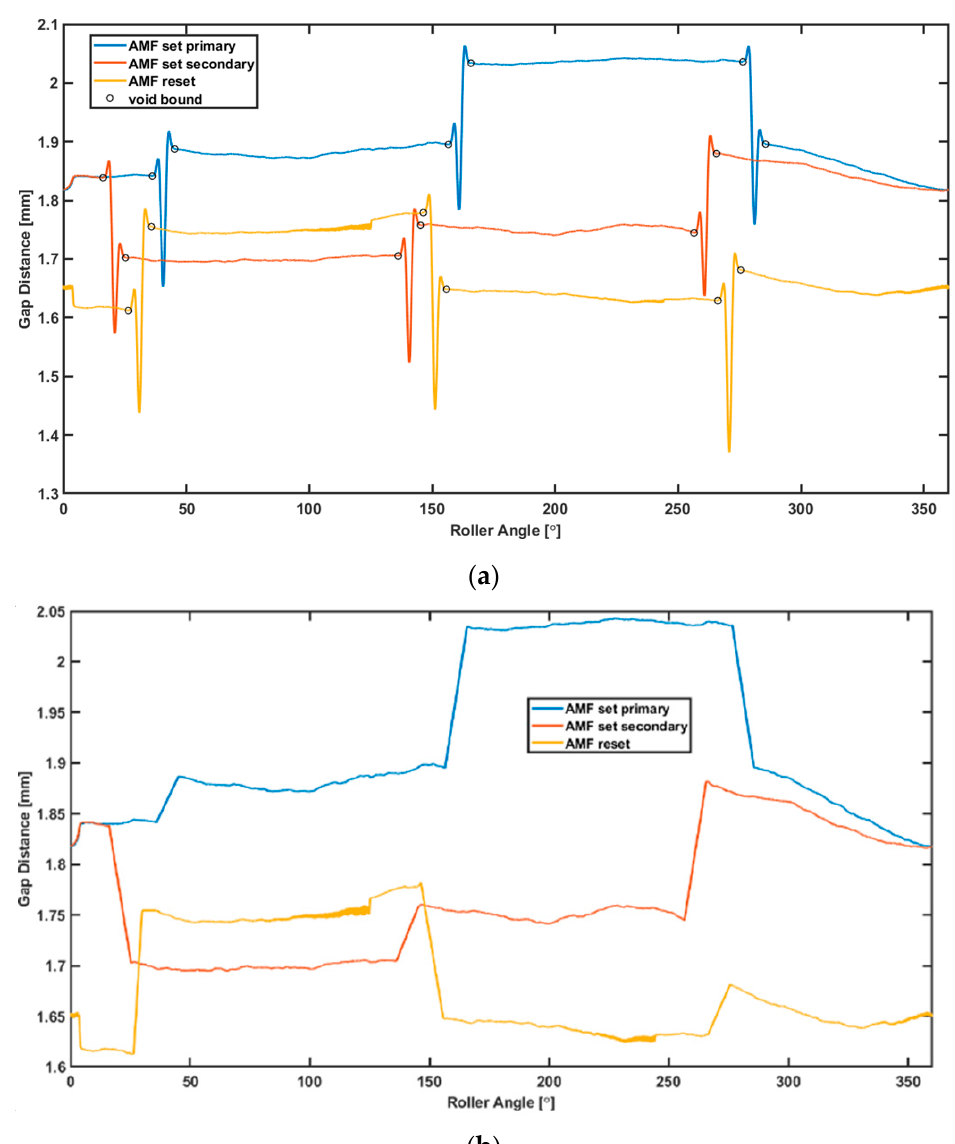
Figure 11. Example of typical BB6 auto-calibration routine results. ( a ) Detection analysis output; ( b ) Validation result after calibration.